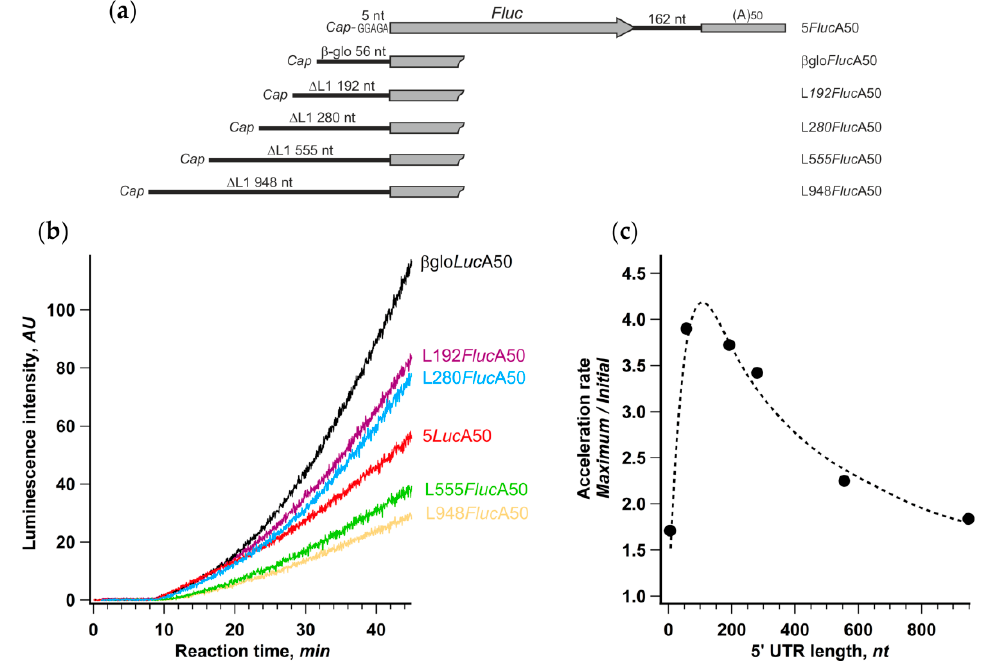
Figure 4. Degree of acceleration depends on the length of 5 ′ UTR. ( a ) Schematic representation of mRNA constructs with different lengths of 5 ′ UTR; ( b ) time course of cell-free protein synthesis directed by the indicated mRNAs; ( c ) dependence of translation acceleration rate on the length of 5 ′ UTR. The values of the acceleration rate were calculated as described in the legend to Figure 1.